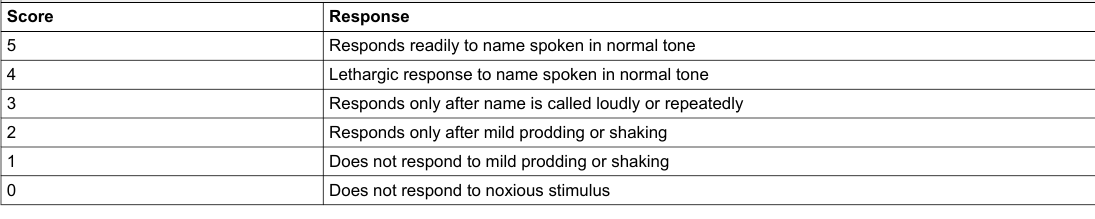
Table 2: Demographic characteristics of the study groups and